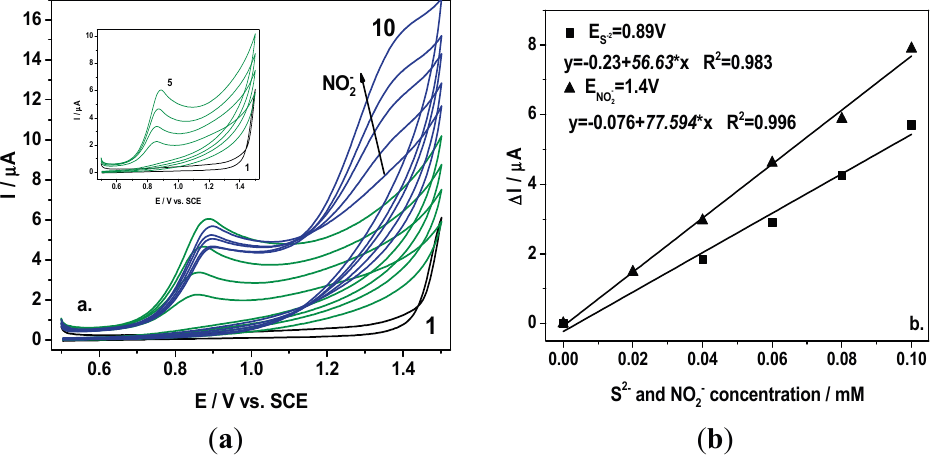
Figure 1. ( a ) Cyclic voltammograms recorded at a BDD electrode in 0.1 M Na 2 SO 4 supporting electrolyte (curve 1) in the presence of 0.02–0.1 mM sulfide (curves 2–5; Inset of figure), and 0.02–0.1 mM nitrite (curves 6–10) at a potential scan rate of 0.05 Vs − 1 in a potential range from +0.5 to +1.5 V/SCE; ( b ) Calibration plots of the current vs .